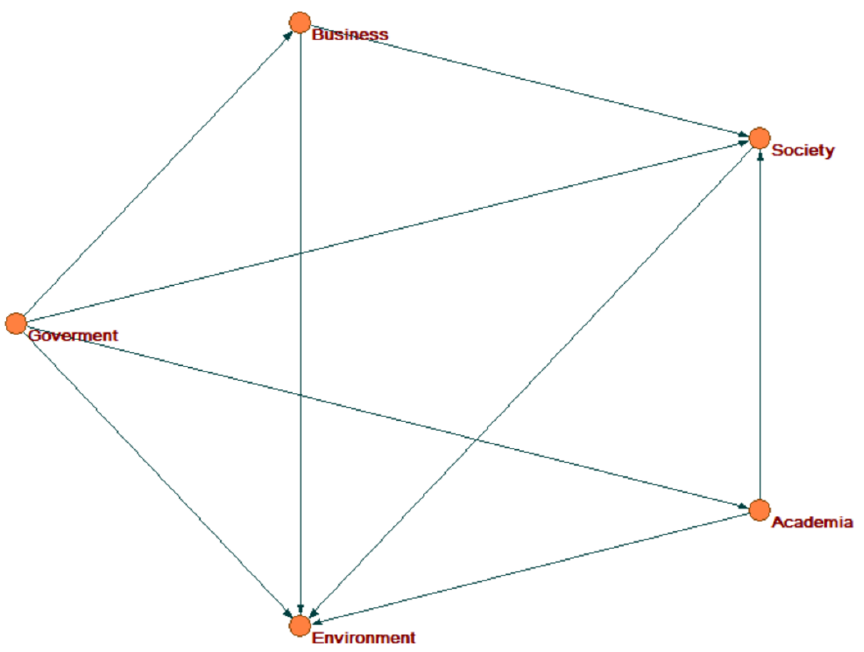
Figure 6. Relationship between the institution sectors and the application sector of SAK’s experiences.